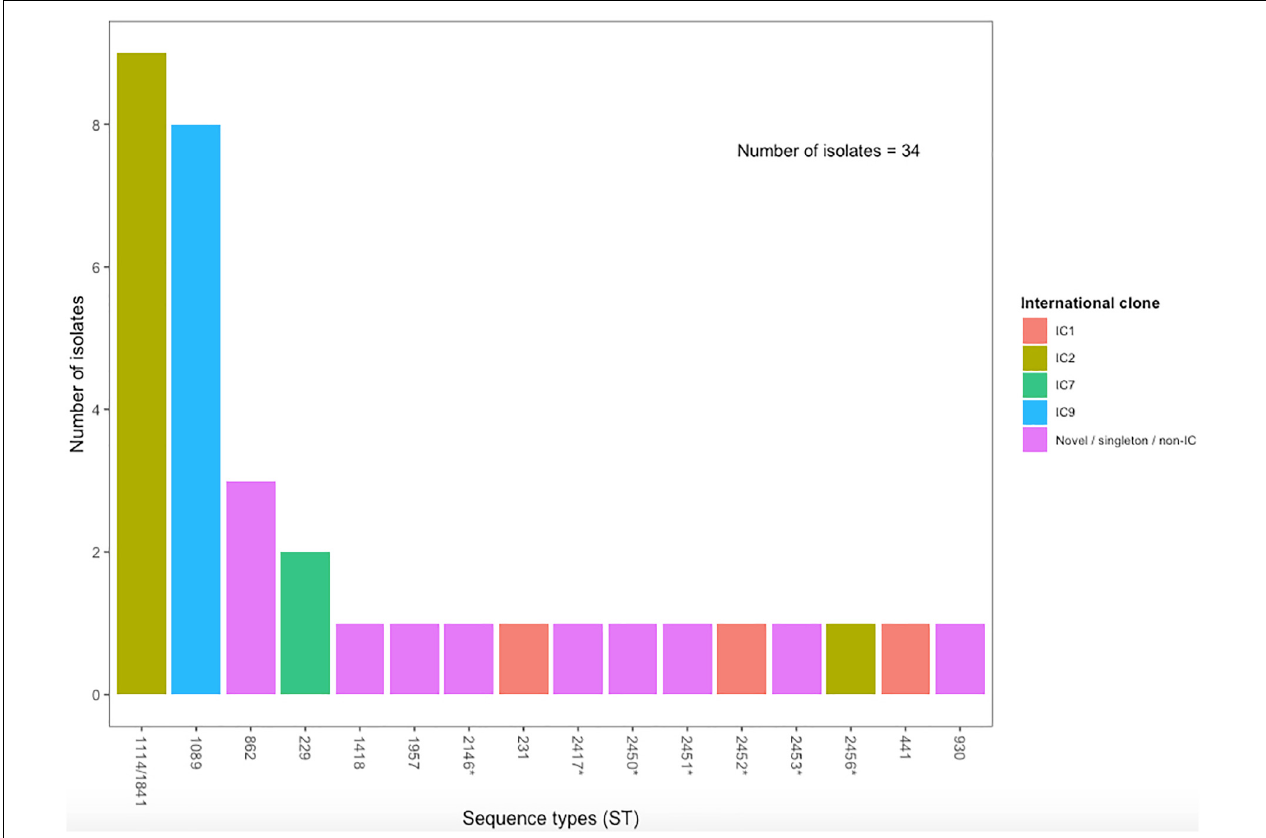
FIGURE 2 | MLST distribution of A. baumannii isolates from OAUTHC, Ife, Osun State and UCH, Ibadan, Oyo State, Nigeria between 2017 and 2019. Bars are colored according to the international clone assignment (20, 34). STs with asterisks are novel STs detected in this study.